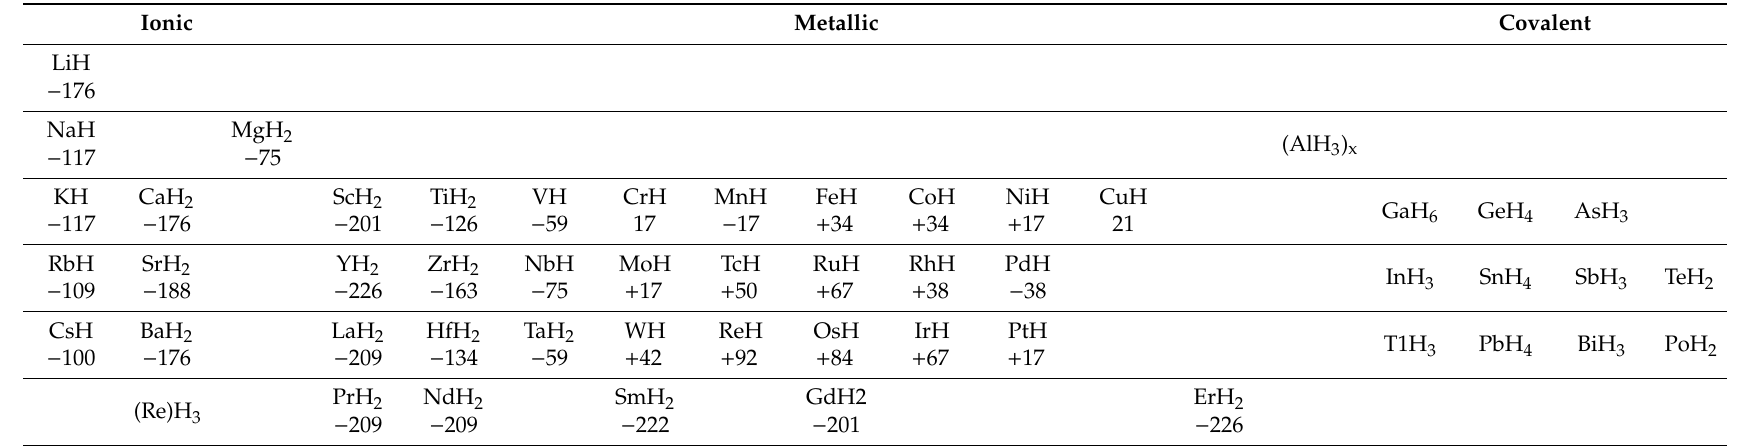
Table 2. Comparison of the heat of formation of hydrides for various metallic elements ( ∆ H f , (kJ / Mol)), data from [129], with permission from author, 1998. Ionic